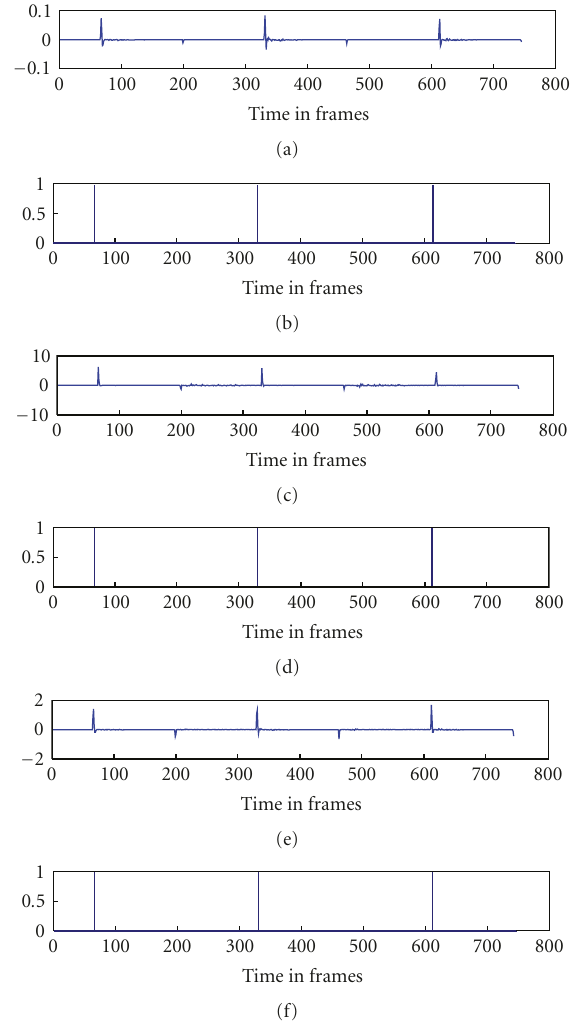
Figure 10: Comparison between the detection functions for the guitar signal (see Figure 9(a)). Plots (a), (c), and (e) are detection ( k ), h o ( k ), and h o ( k ), respectively, and plots (b), functions h o a r b (d), and (f) are the onsets localised correspondingly using these detection